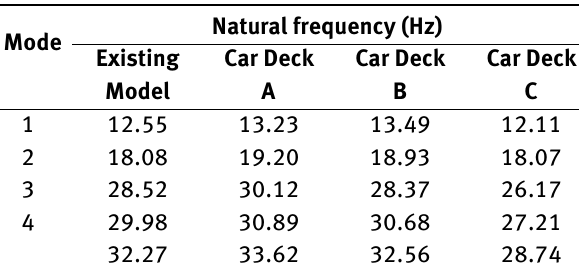
Table 3: Natural frequencies as functions of mode shapes of the